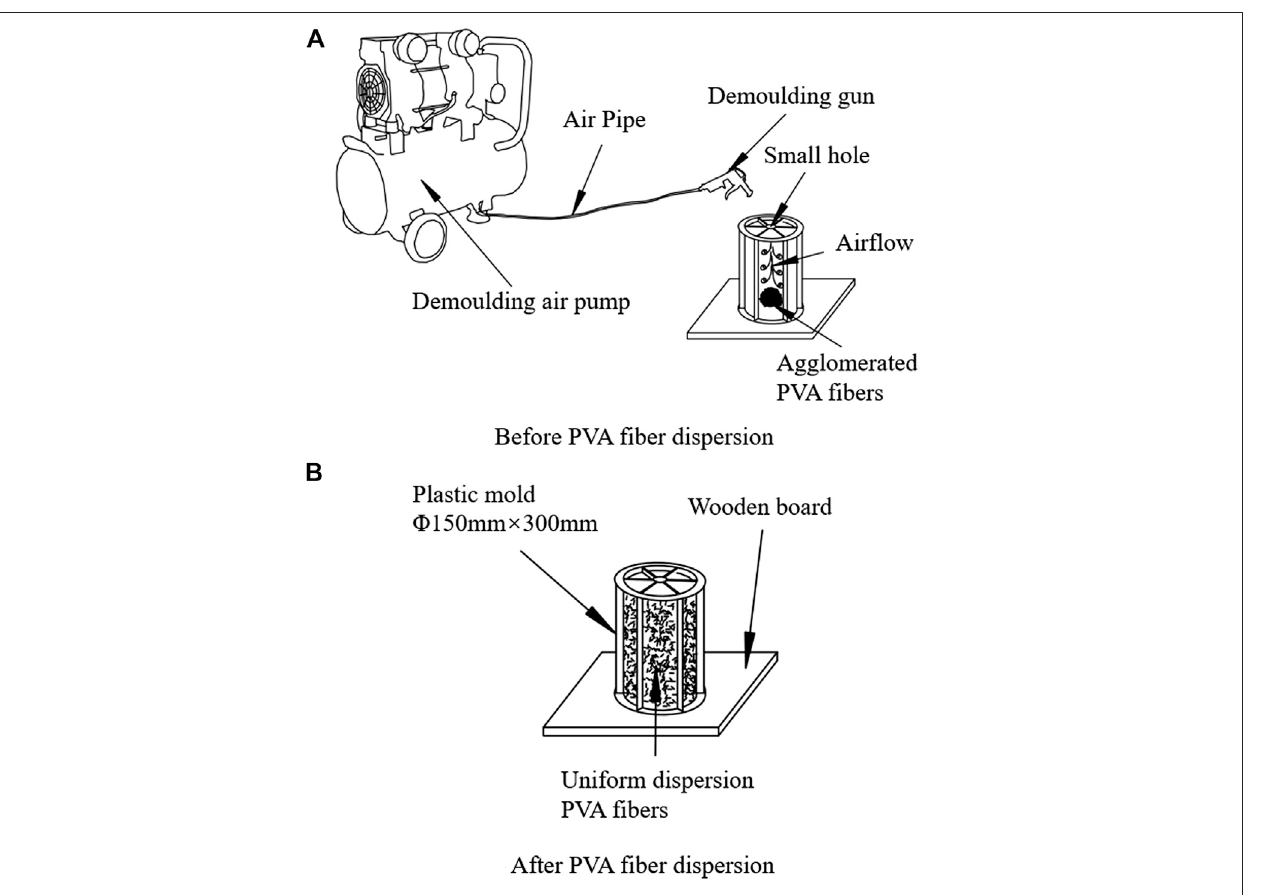
FIGURE 3 | The uniform dispersion PVA fi ber by a demolding air